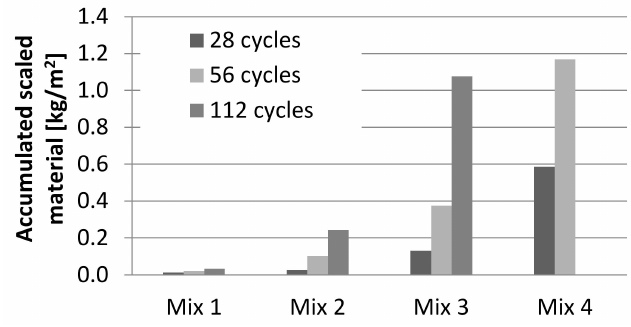
Figure 16. Mean values of the accumulated mass of scaled material per area of freezing surface after 28, 56 and 112 cycles for concrete with di ff erent amounts of GGBS replacement.